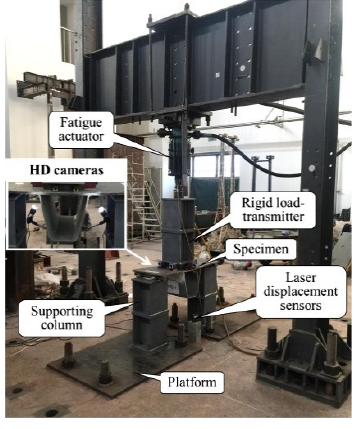
Figure 3. Fatigue test rig [8].